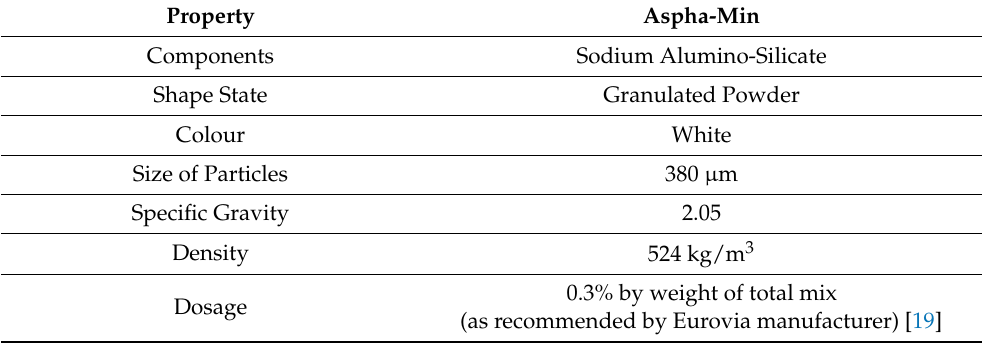
Figure 4. Granulated powder of Aspha-Min. Table 6. The physical properties of Aspha-Min.